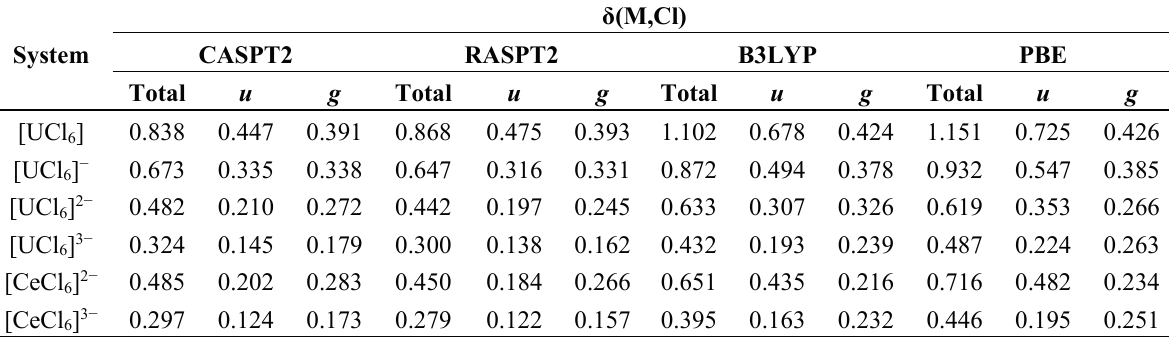
Figure 6. Variation of the U–Cl delocalisation index, δ , as a function of oxidation state. Cross-hatched regions correspond to the gerade contributions to δ . All values are given in a.u. Table 7. Delocalisation indices, along with decomposed gerade ( g ) and ungerade ( u ) contributions, evaluated at theoretically optimised geometries. All values are in